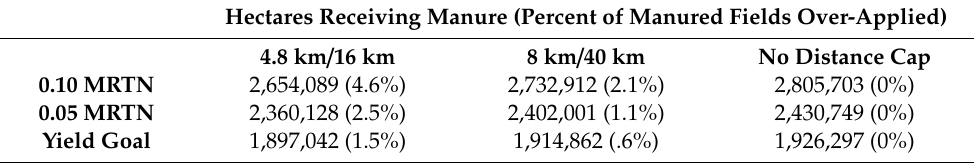
Table 6. Hectares Receiving Manure and Extent of Over-application.